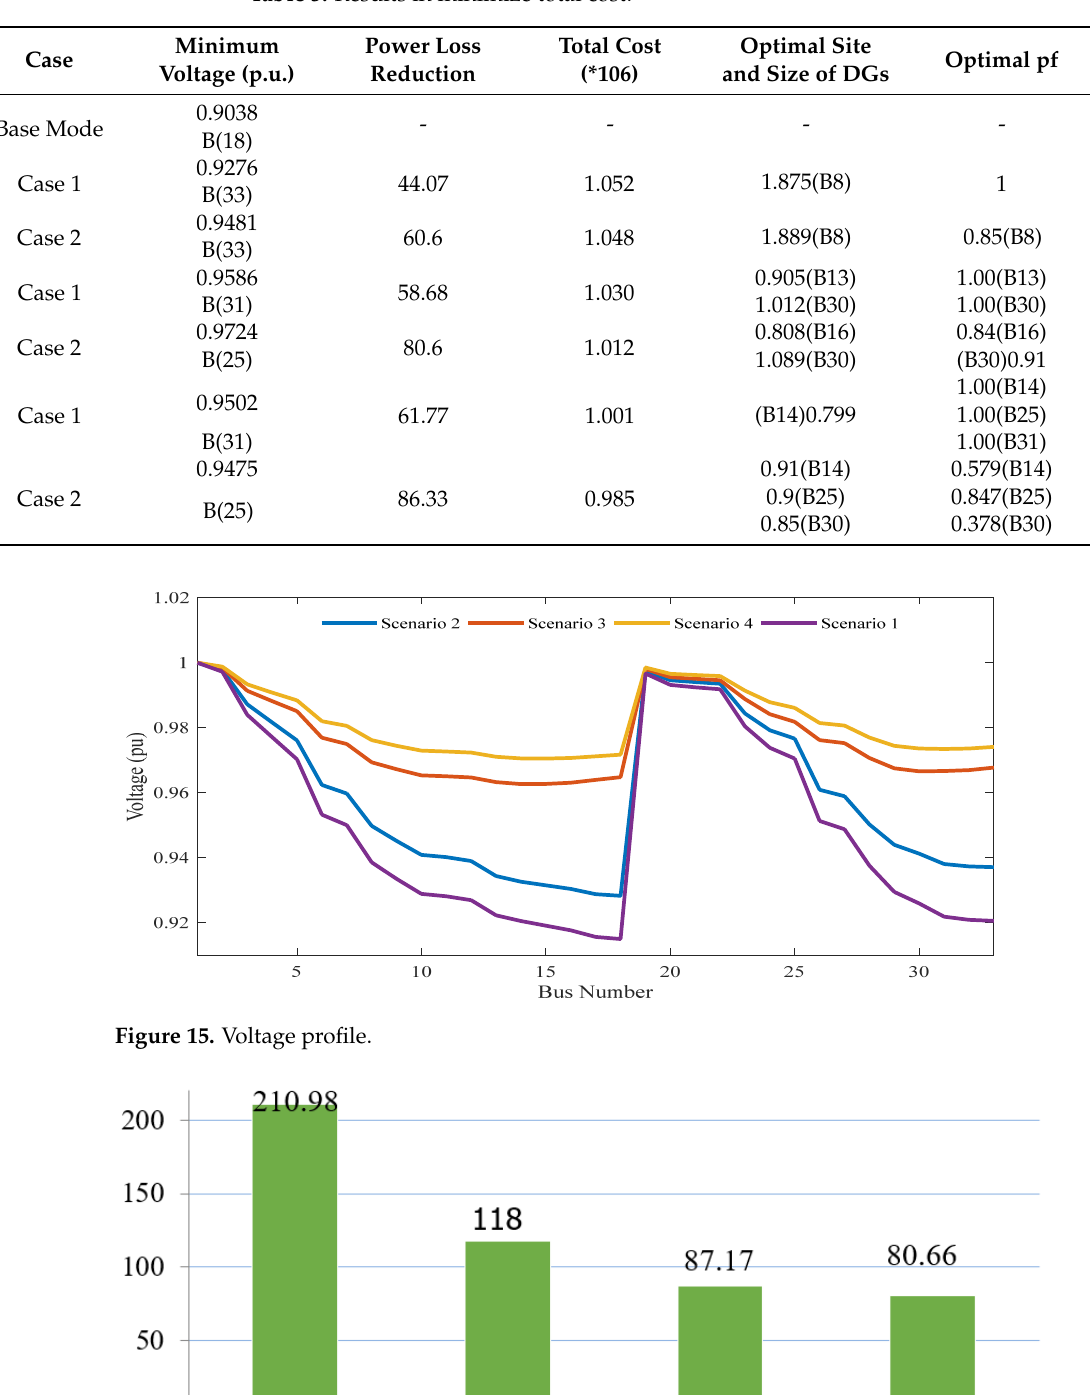
Table 3. Results in minimize total cost